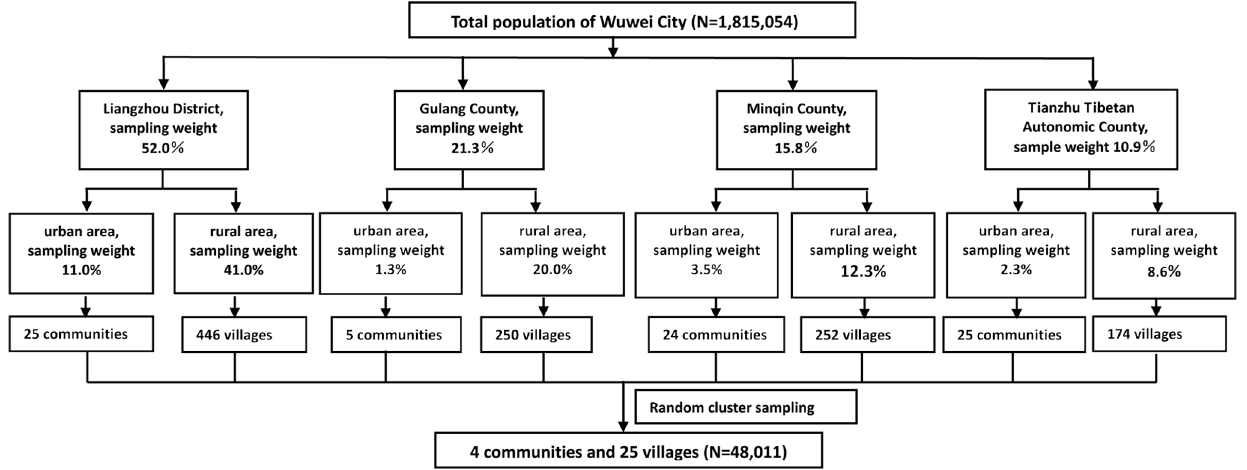
Figure 1. Flow chart summarizing the sampling method.